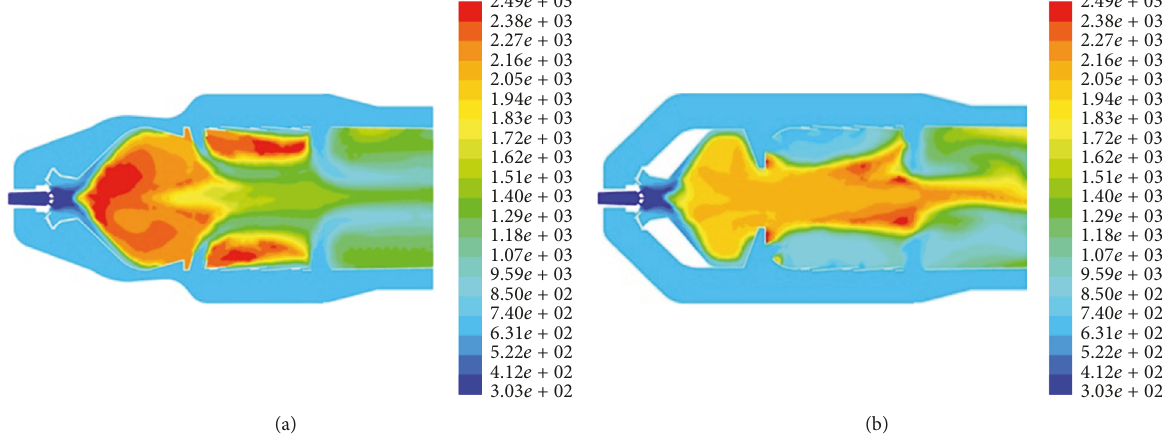
Figure 15: Temperature field in the longitudinal section of the combustor, K: (a) modified design 1; (b) modified design